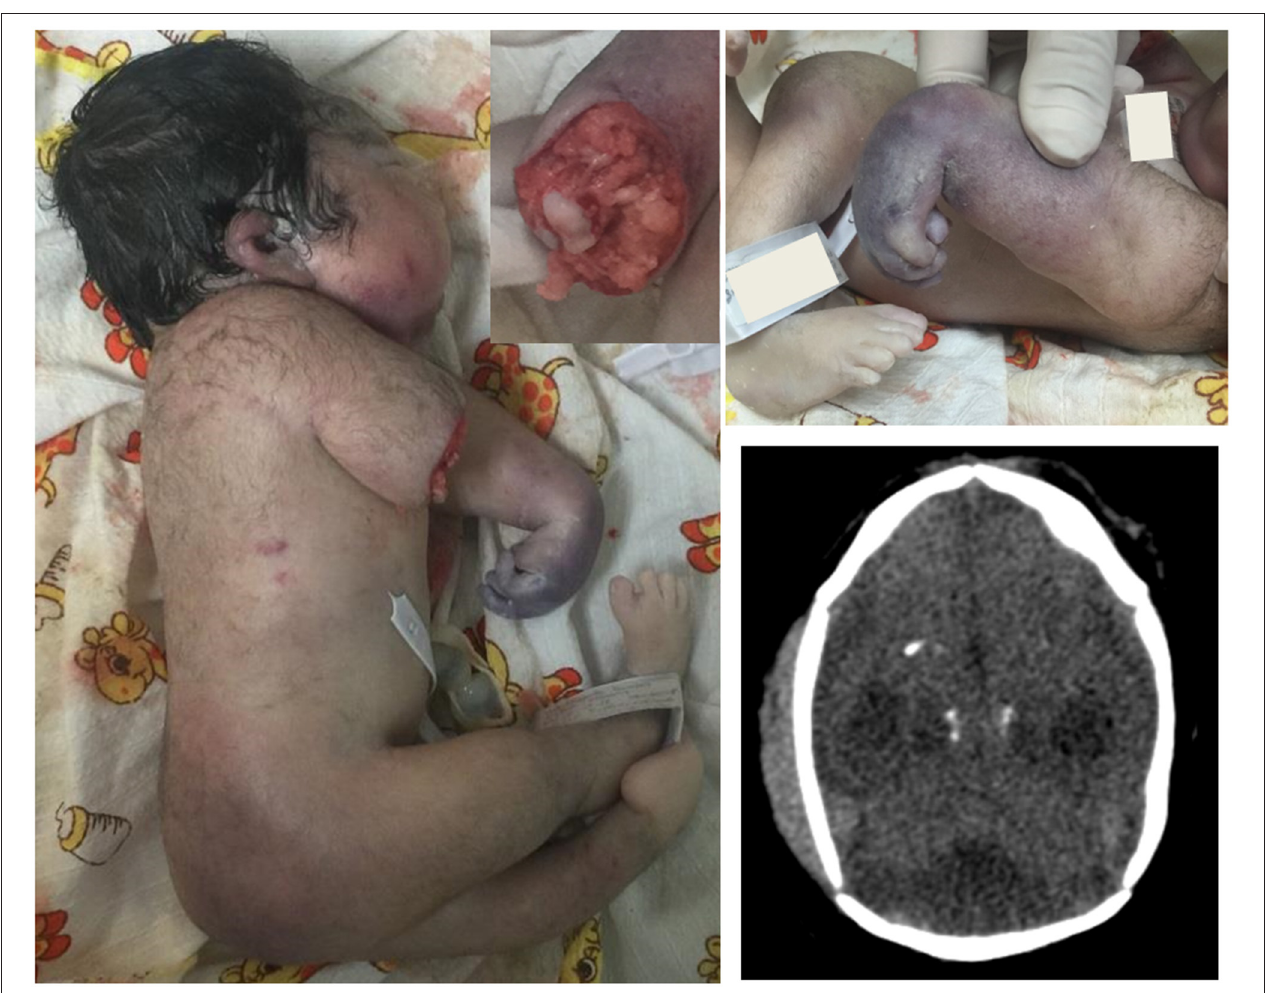
FIGURE 1 | (A) In this picture it is appreciate the patient phenotype with arthrogryposis and the absence of the distal part of the right arm The frontal view of the arm injury is inserted in the upper part of the photo. (B) Observe cyanotic coloration in the distal left arm and hand in comparison of the foot. (C) Axial-cut cranial tomography showing subcortical